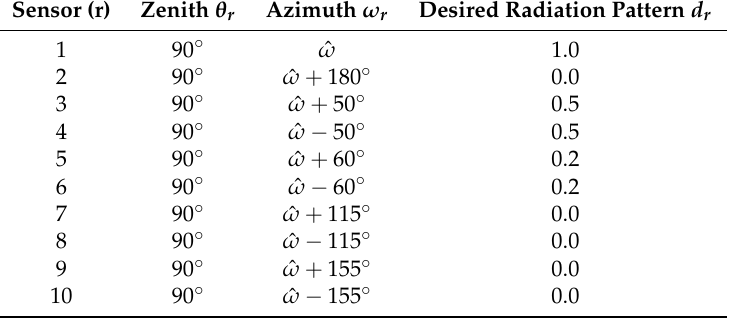
Table A1. Beamformer restrictions of the uniform and circular array (UCA) with 6 dipoles: ˆ ω is the generalized